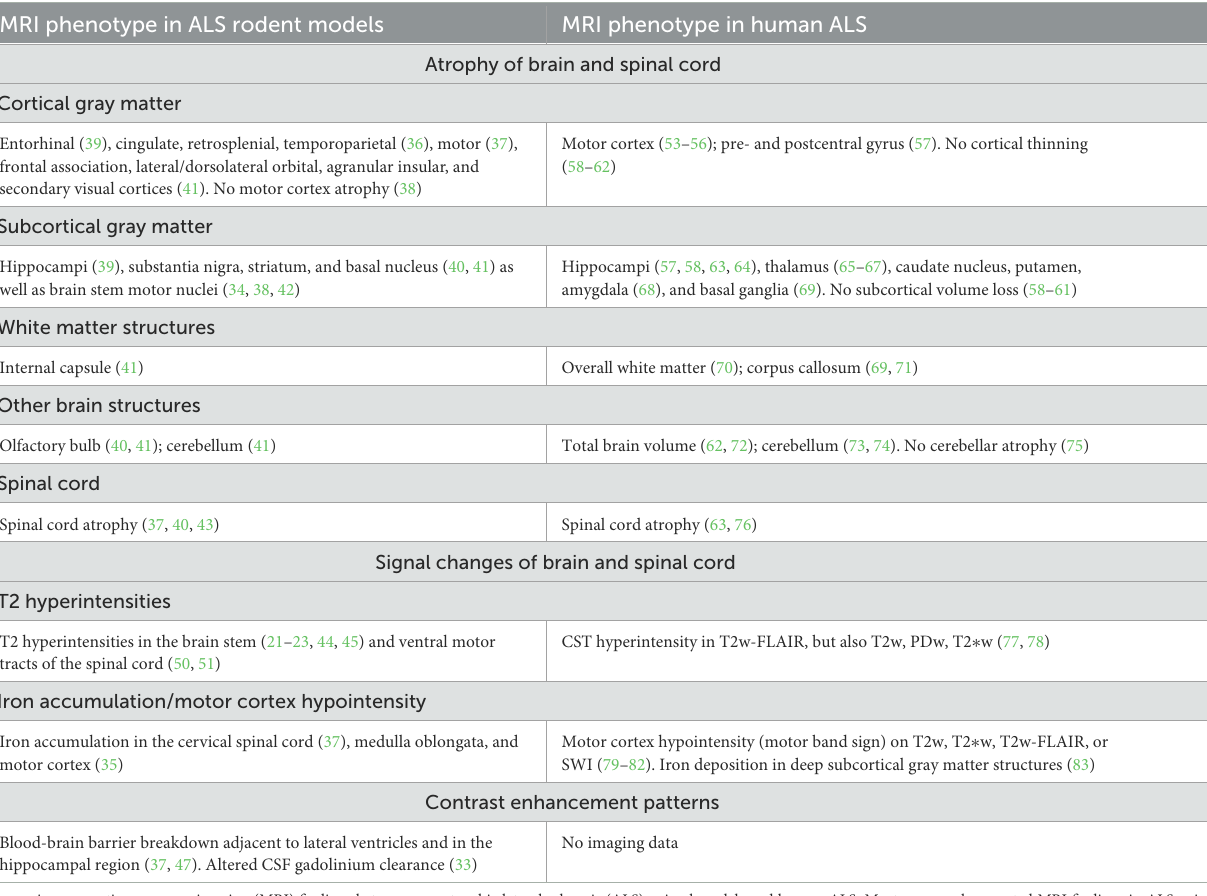
TABLE 1 Synopsis of brain and spinal cord magnetic resonance imaging findings in amyotrophic lateral sclerosis (ALS) animal models. MRI phenotype in ALS rodent models MRI phenotype in human